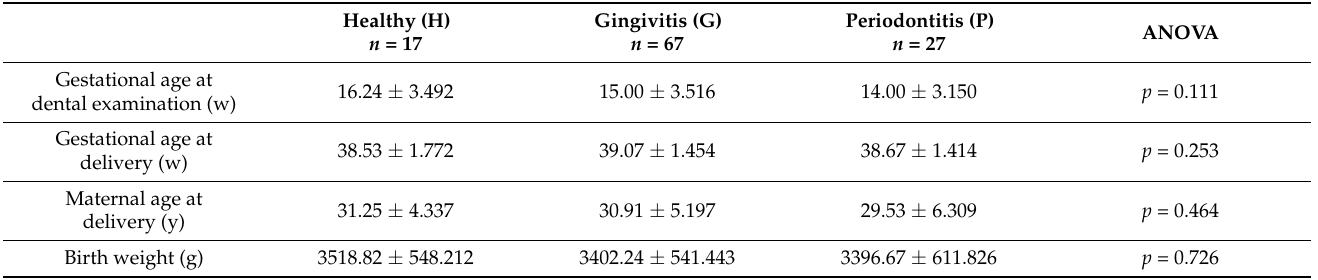
Table 1. Sample characteristics in different dental status groups. Results are shown as means ( ± SD).